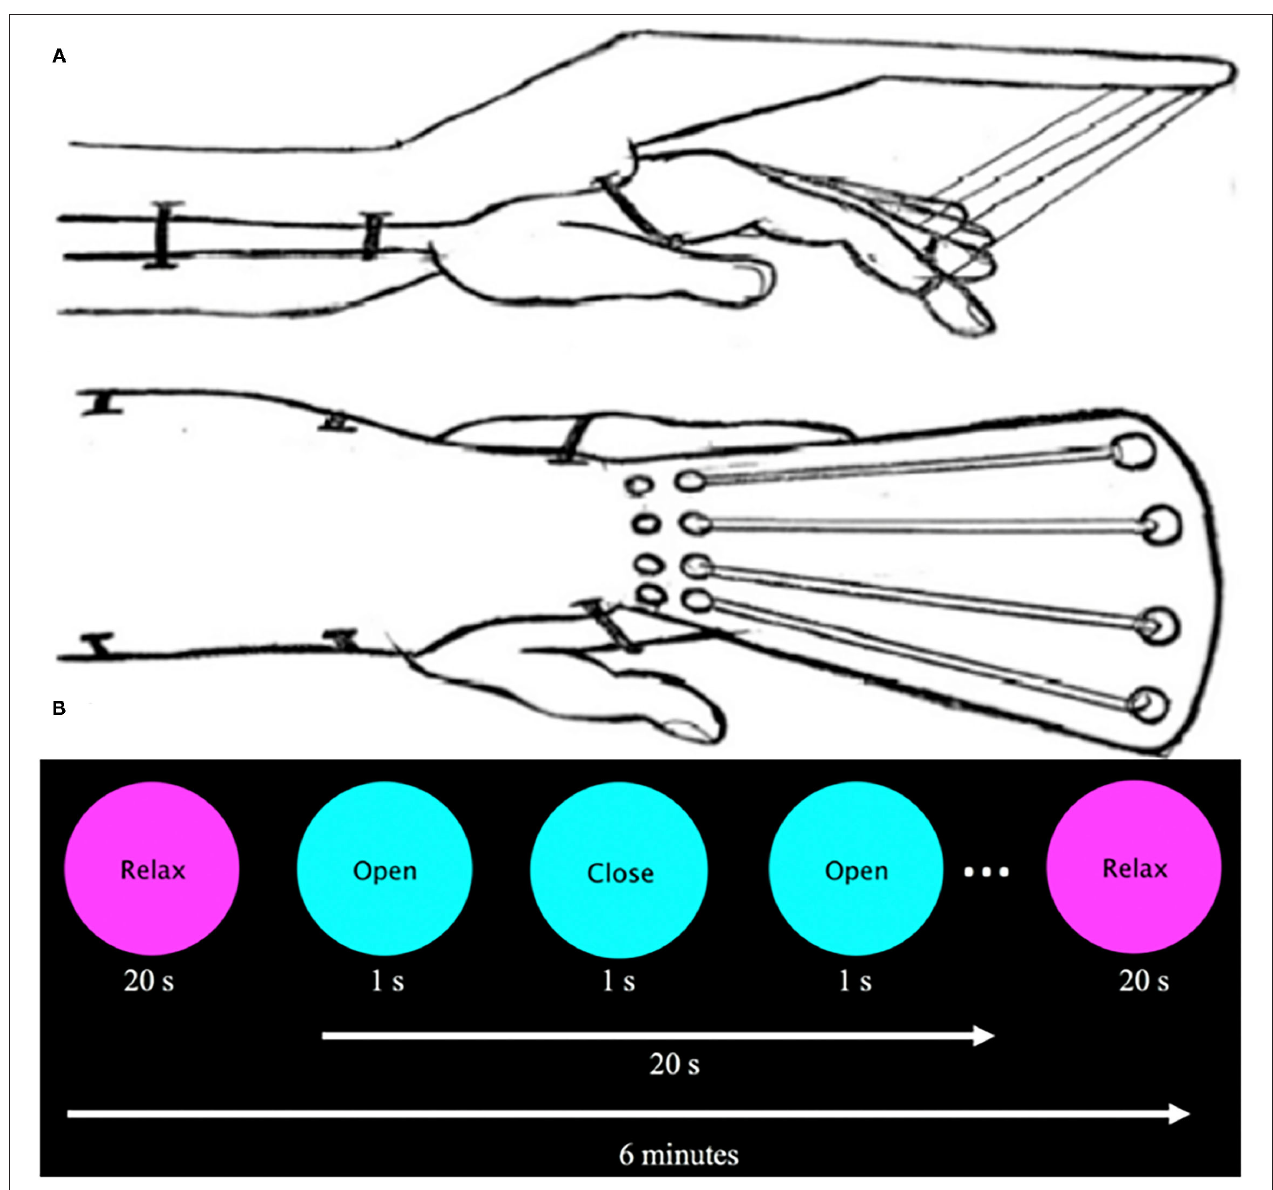
FIGURE 2 | (A) Sketch of assistive finger extension device. This device assists finger extension of stroke participants with spasticity via elastic bands (Theraband: 10.7N resistance at 100% elongation, 15.1N at 200%) that are supported by an outrigger on the dorsal part of the hand. Velcro straps attached to the patient’s first four digits and were connected to an elastic band. A plastic brace served to stabilize the participant’s forearm and wrist as they were instructed to flex and extend the digits. (B) Visual presentation prompt. The visual prompt was presented on a screen inside the bore and read “Relax” centered in a magenta circle (20s) and “Open/Close” centered on a cyan circle (20s, 1Hz) for